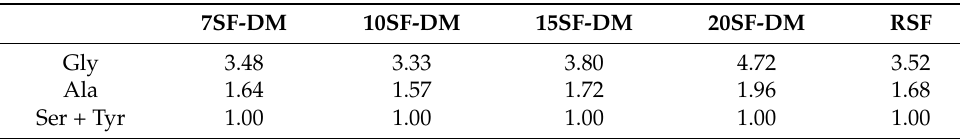
Table 2. Amino acid composition of fractionated SF. The values of Gly and Ala were normalized by those of Ser + Tyr as 1.